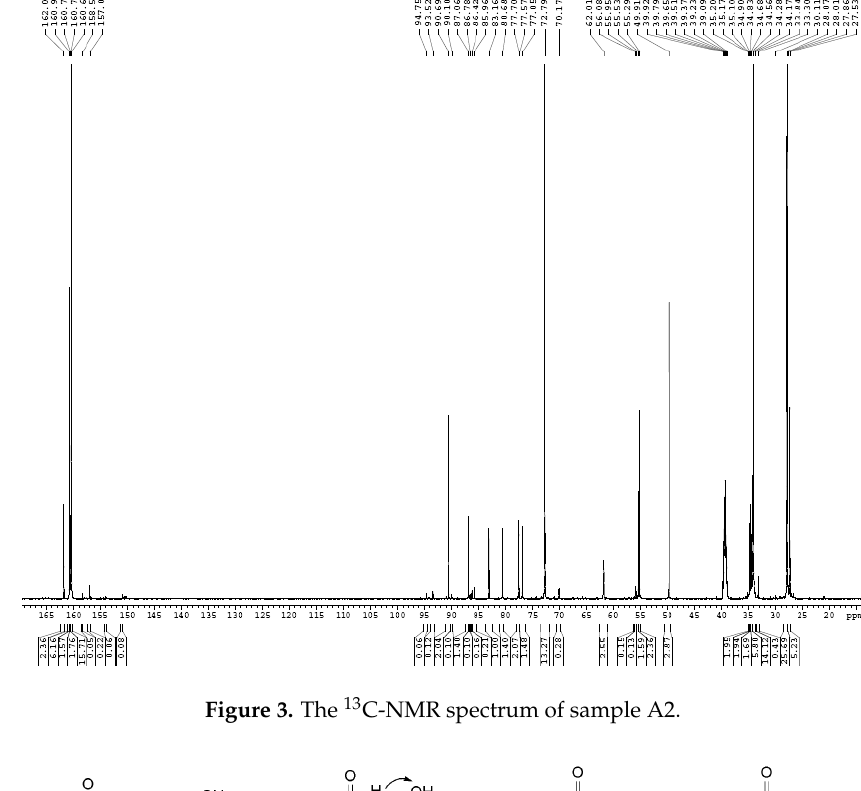
Figure 3. The 13 C-NMR spectrum of sample A2.